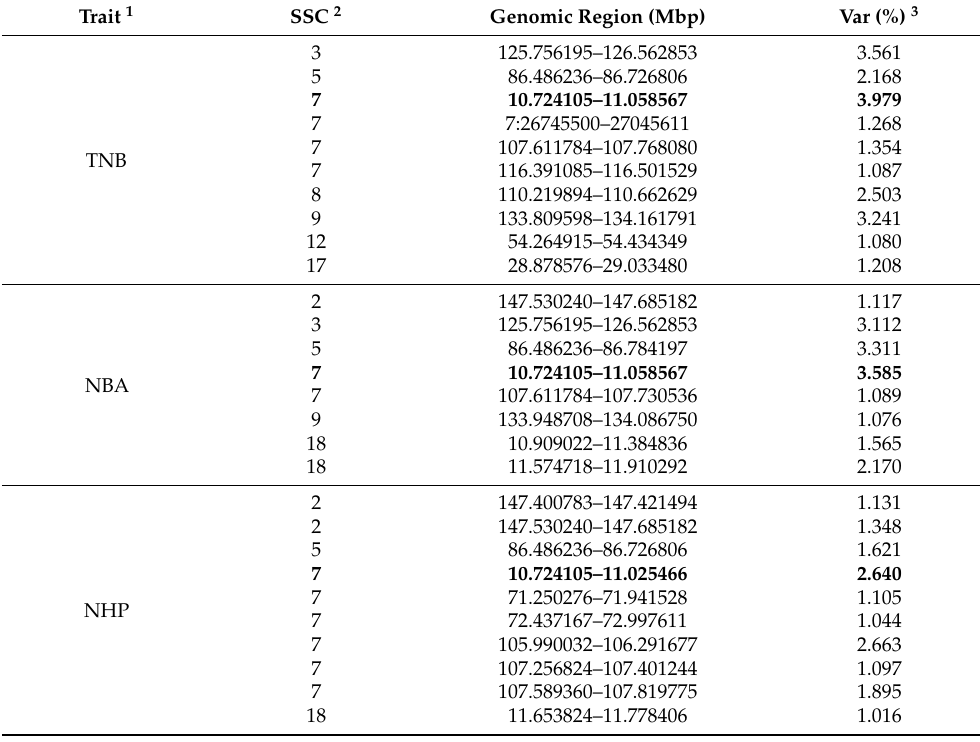
Table 4. Relevant genomic regions for litter